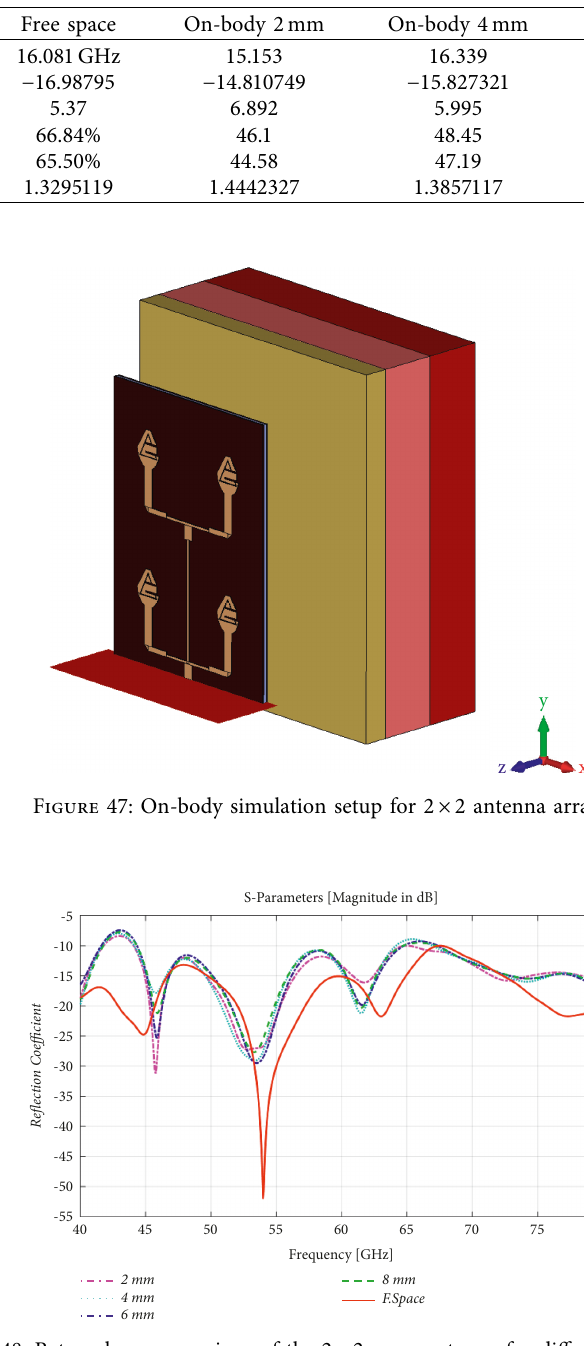
Table 6: On-body comparison of the 1 × 4 array antenna for different distances.